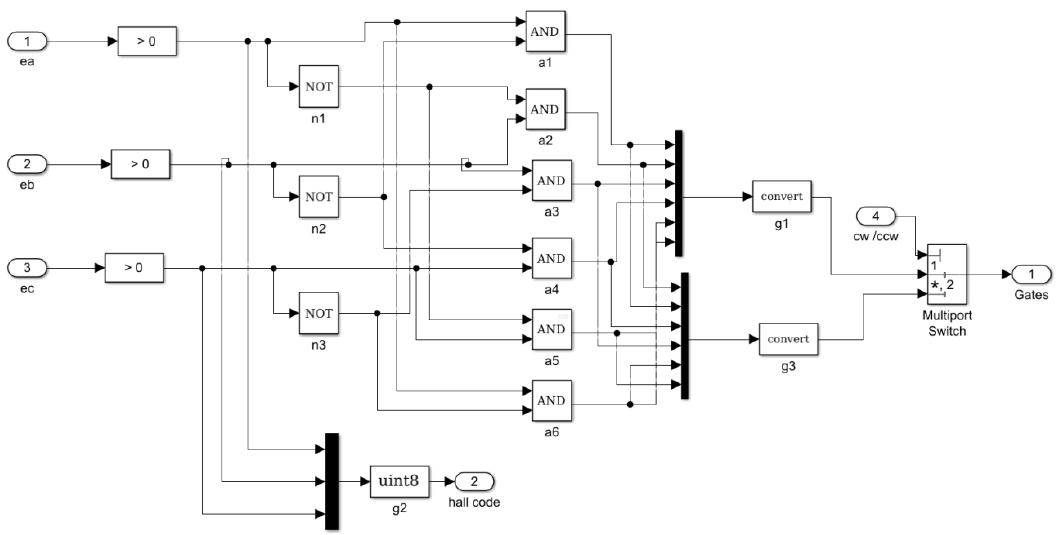
Figure 6. Digital logic from truth table in PWM-PWM mode.